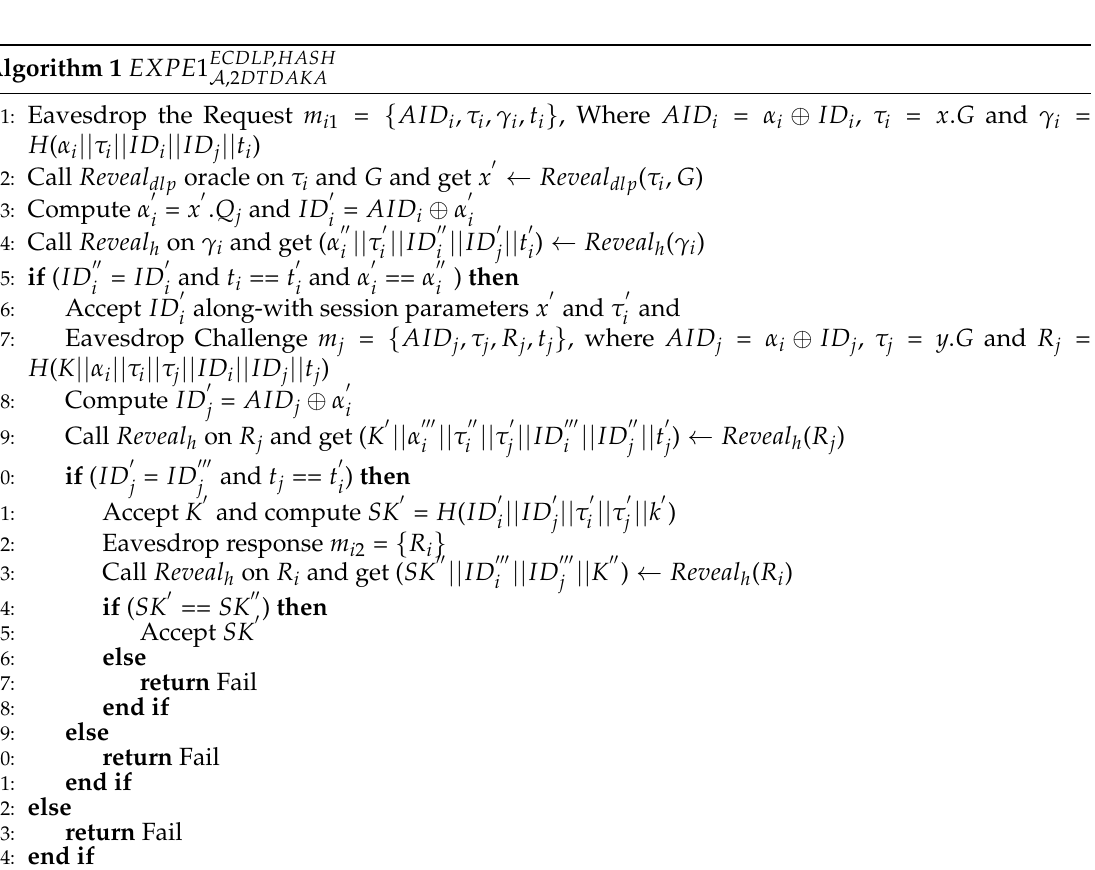
(Algorithm 1) EXPE 1 ECDLP , HASH against the two party device-to-device authenticated key agreement A ,2 DTDAKA